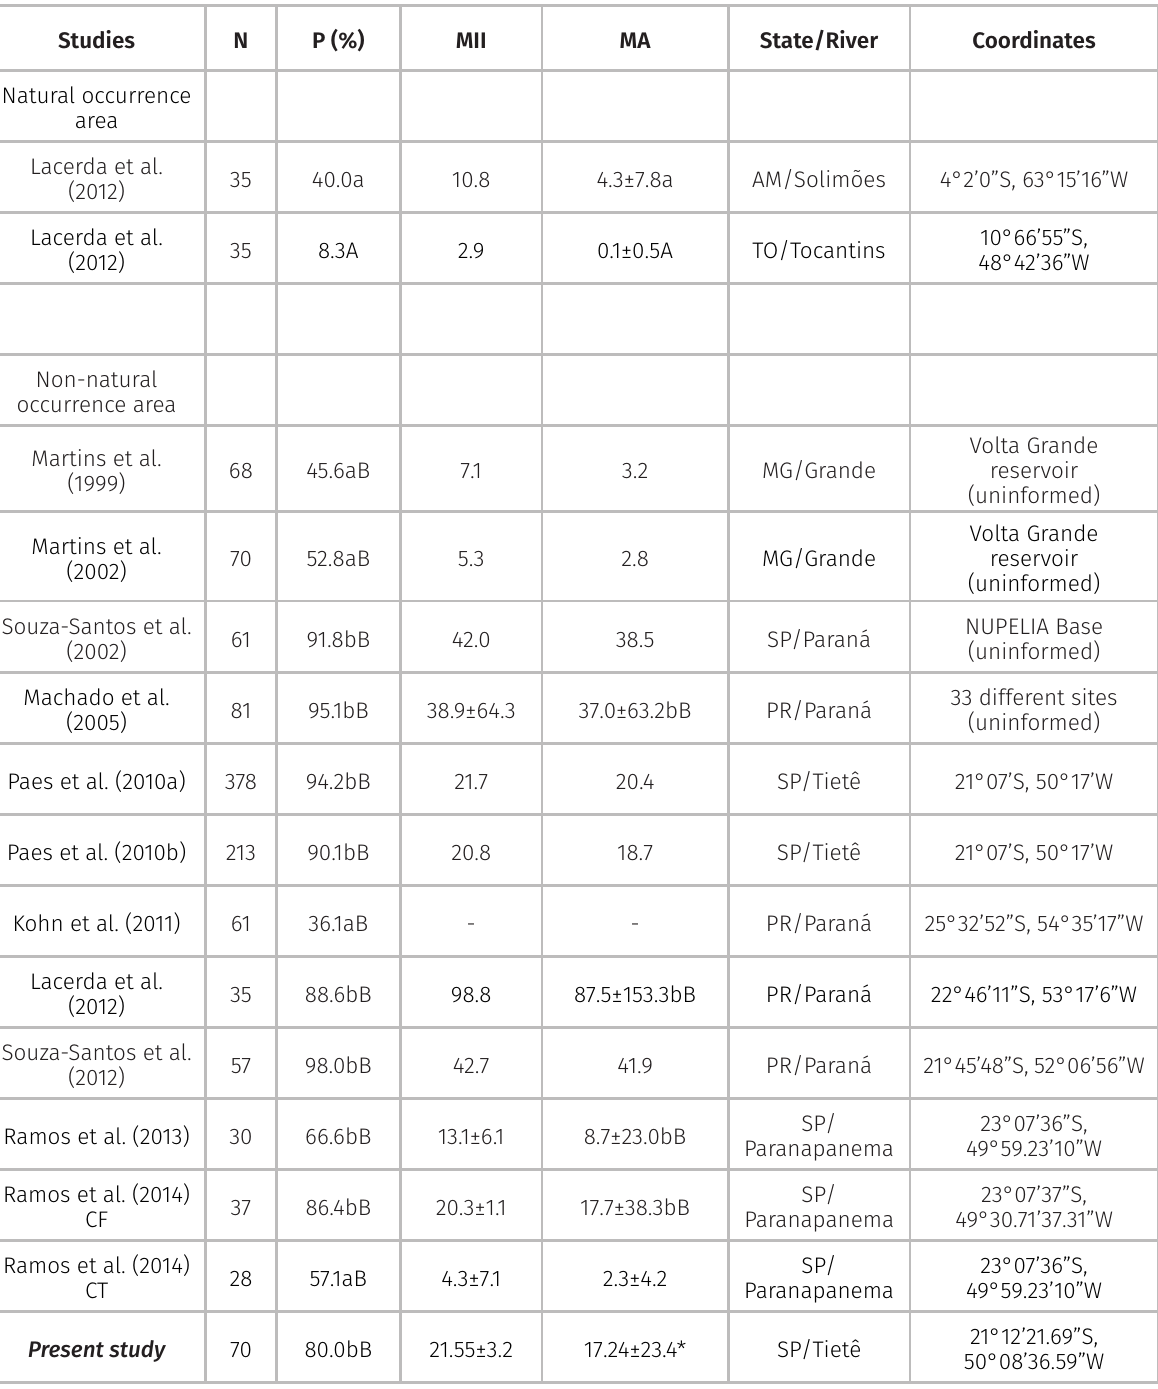
Table I. List of studies recording Austrodiplostomum compactum metacercariae in the eyes of Plagioscion squamosissimus in Brazil. Number of specimens examined (N), prevalence (P), mean intensity of infection (MII) and mean abundance (MA). Mean values followed by standard deviation when available; different small letter = significative difference ( p <0.05) between the natural (Solimões River) and non-natural occurrence area; different capital letters = significative difference ( p <0.05) between the natural (Tocantins River) and non-natural occurrence area. CF = area close to cage fish farm; CT = area not influenced by cage fish